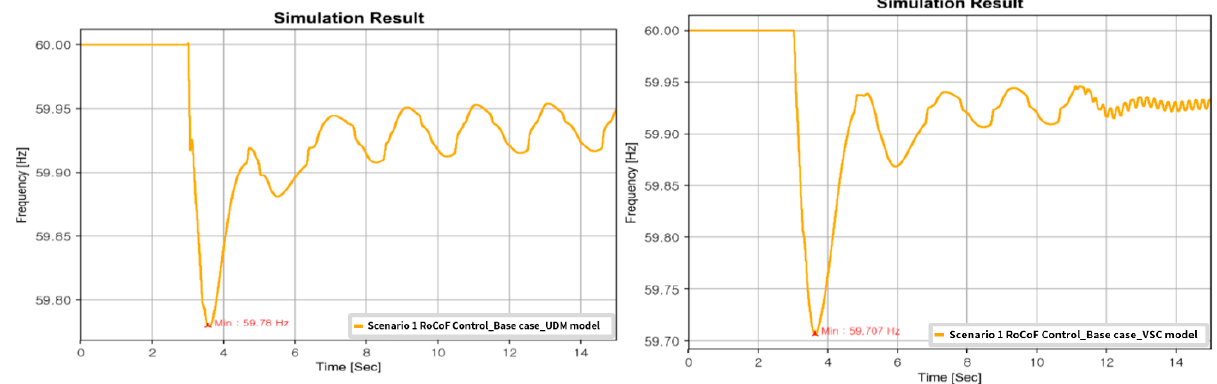
Figure 9. Frequency response characteristics by the HVDC model: UDM HVDC ( left ) and VSC HVDC ( right ).